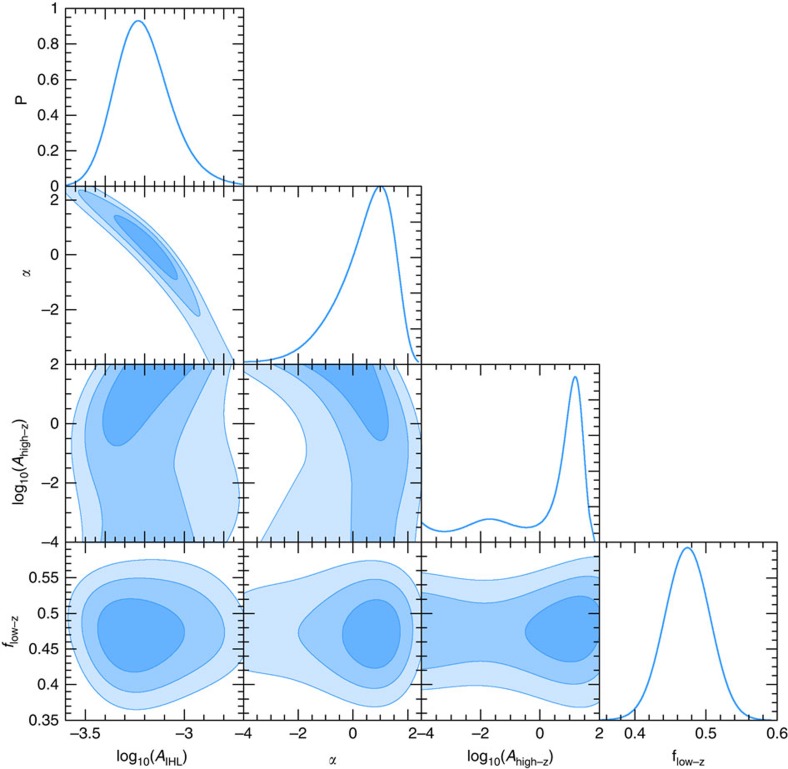
Probability distributions of fitted model parameters.Here we show the probablity density distributions for our fitted model parameters log10(AIHL), α, flow-z, and log10(Ahigh-z) corresponding to the distribution from 8≤z≤13. The single curves on the outermost column of each row, labelled with a ‘P', show the marginalized probability distribution for each parameter labelled on the bottom of the figure. Contour regions to the left of these probability distributions show how the parameters scale with one another. Each of the shaded regions in the contours correspond to the 1, 2 and 3σ uncertainty ranges.